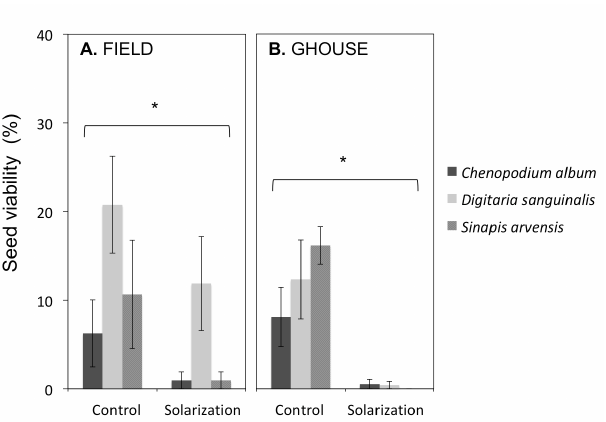
Figure 3. Mean ± SEM seed viability of three weed species after four weeks of burial in non-treated control and solariza- tion treatments in (A) FIELD and (B) GHOUSE experiments. Asterisks (*) denote statistically significant treatment effects at α = 0.05.